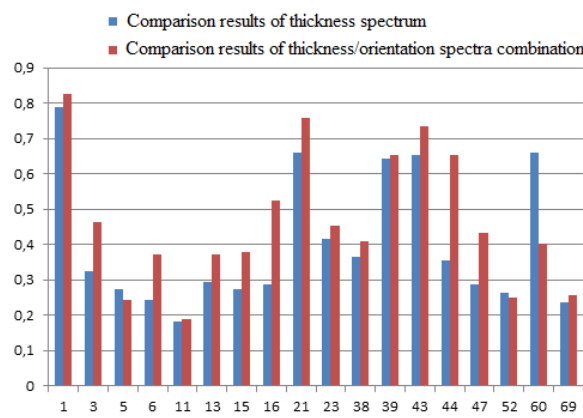
Figure 12: Top closest shapes for the requested shape. Thickness spectrum was used.